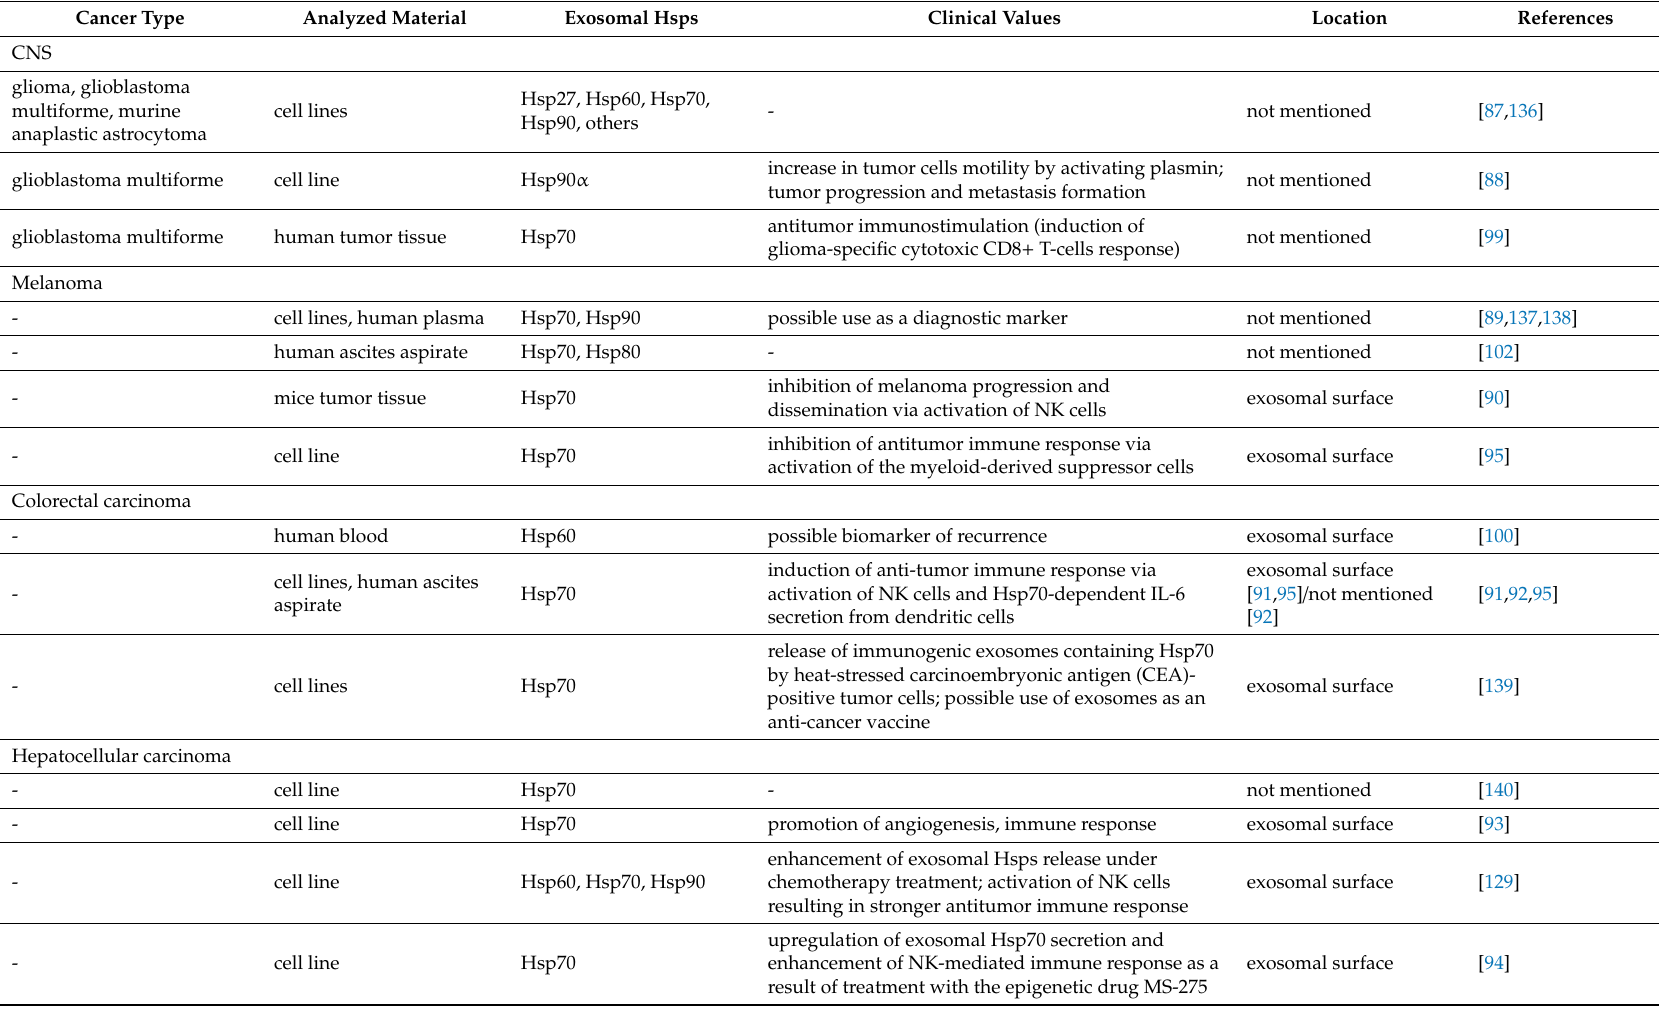
Table 1. Summary of the methodology of the exosomes determination and their clinical